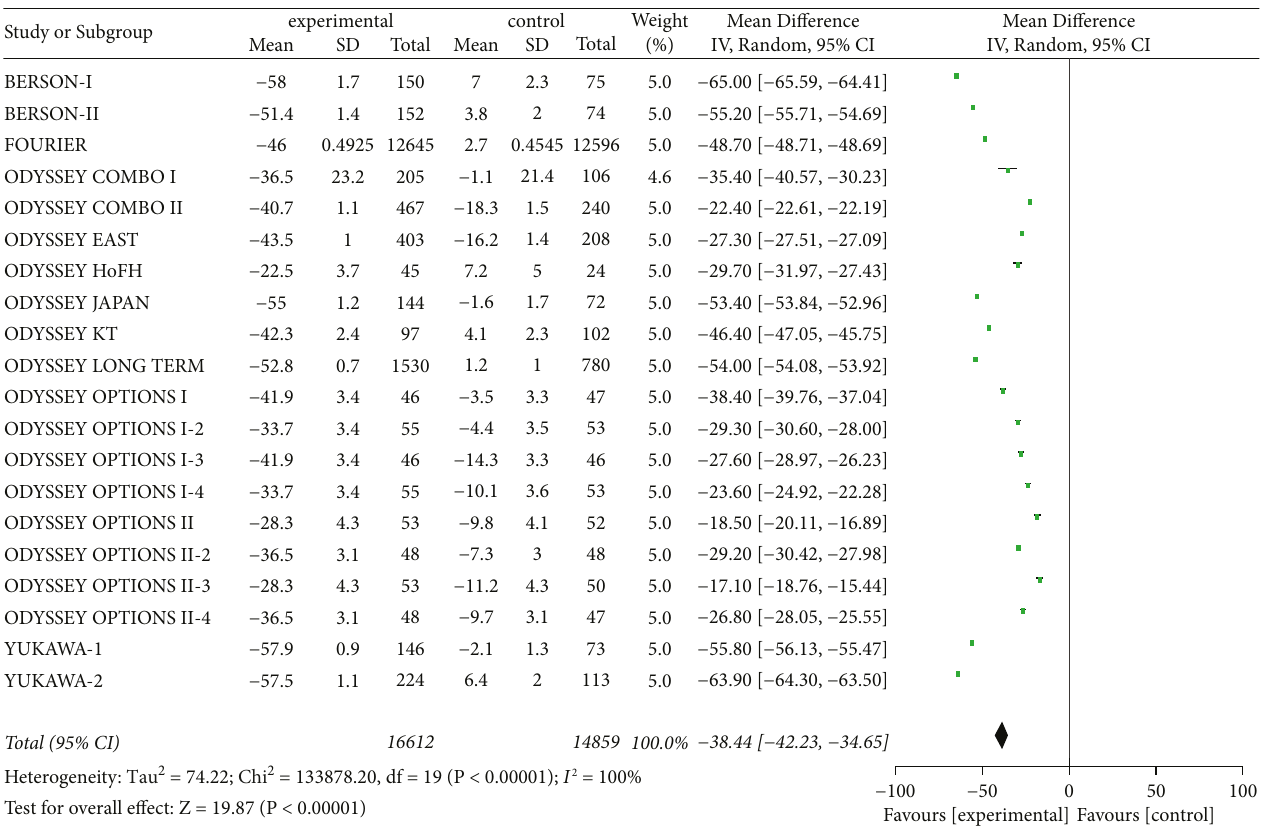
Figure 9: Comparison of the reduction of serum ApoB (%) from baseline between control group and experimental